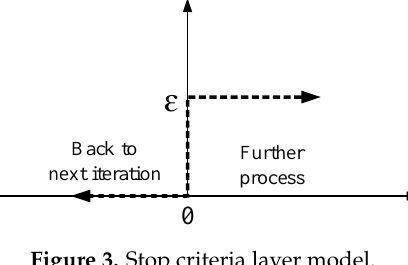
Figure 3. Stop criteria layer model.